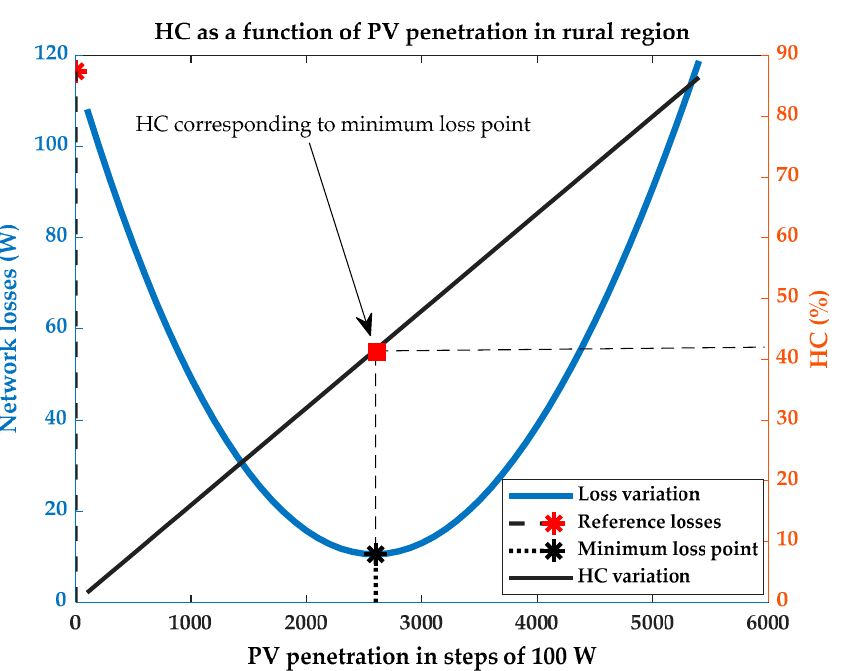
Figure 10. HC variation with network losses and HC corresponding to optimal loss point of net ‐ work.